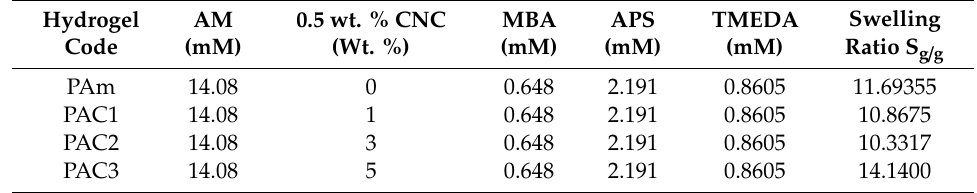
Figure 1. Schematics of polyacrylamide– cellulose nanocrystal (PAC) hydrogel formation. Table 1. Feed composition of PAC hydrogels.